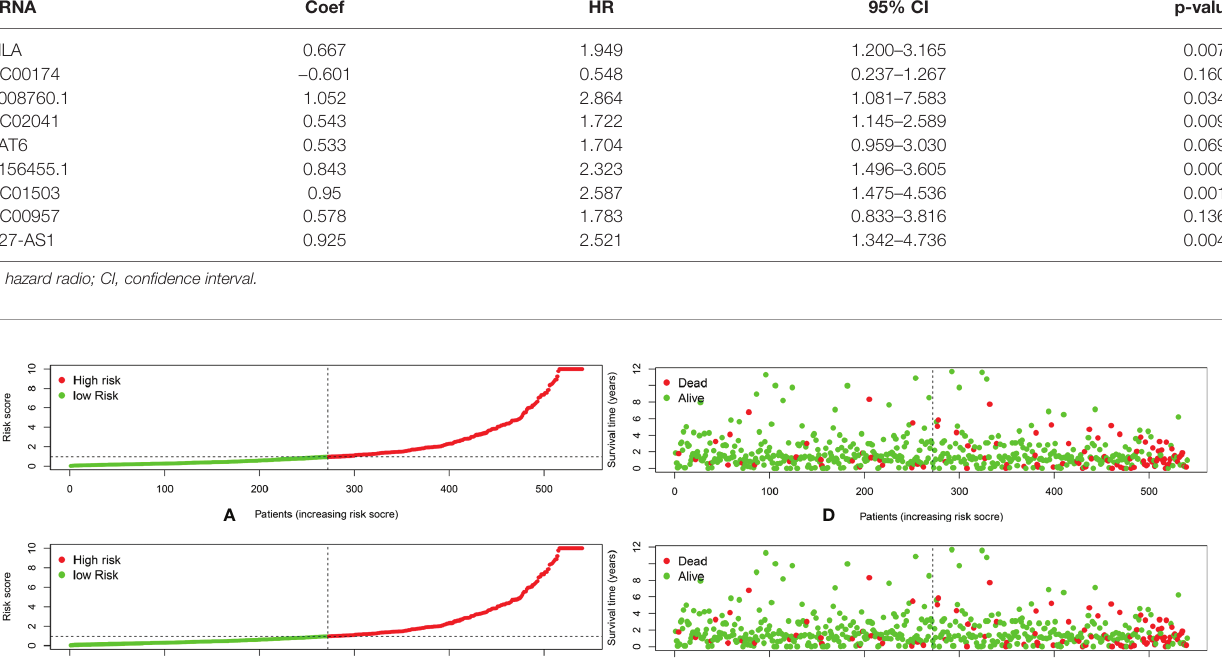
TABLE 1 | ARlncRNAs applied to new prediction model. lncRNA Coef HR 95% CI p-value NKILA